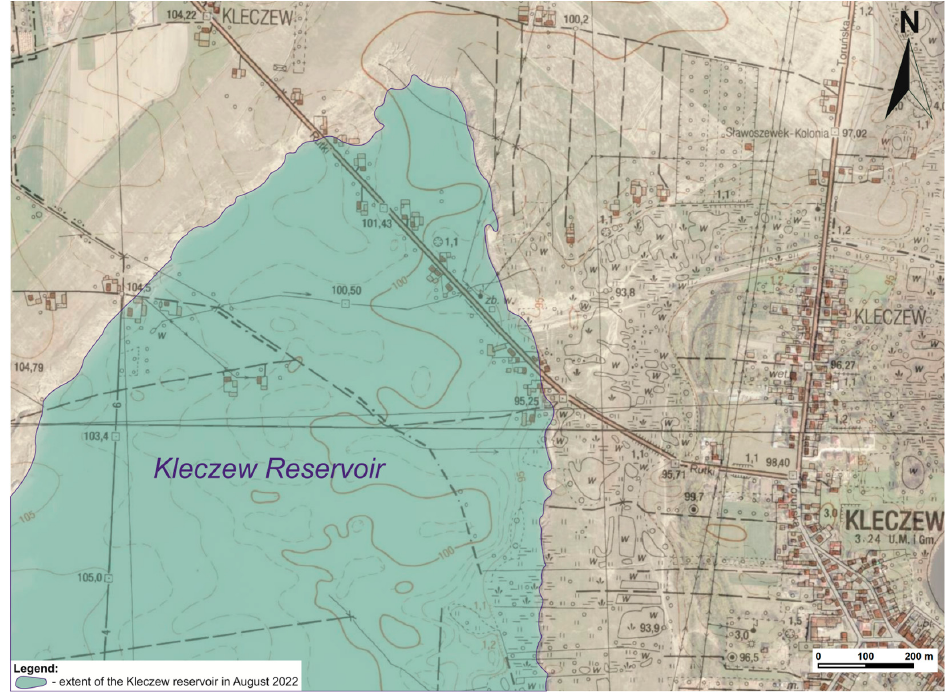
Figure 9. Range of the new post-mining water reservoir Kazimierz P ó łnoc in August 2020 on the background of a topographic map from the 1980s showing the historic ordinate of the surface water level (source: https://mapy.geoportal.gov.pl/imap/Imgp_2.html?gpmap=gp0, accessed on 20 July